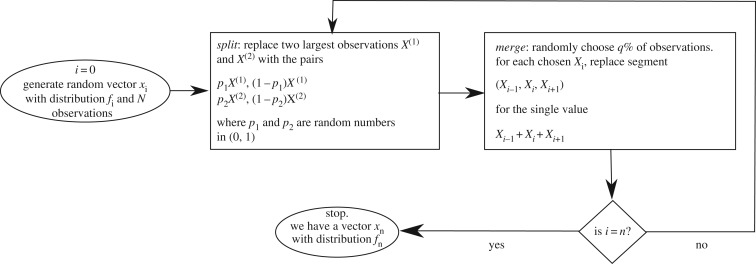
Flowchart of of the split–merge process.